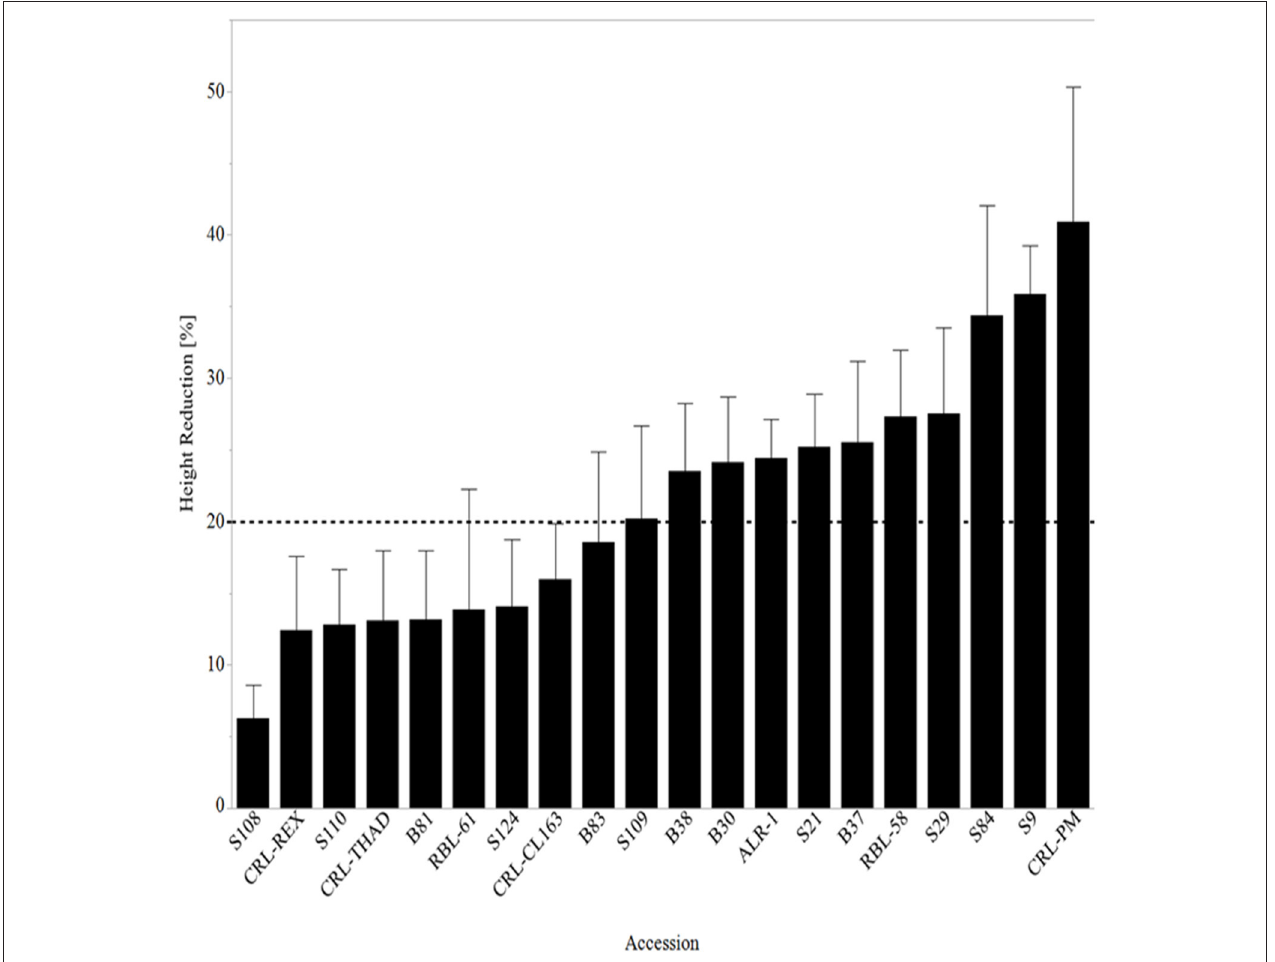
FIGURE 2 | Mean height reduction 28 days after heat stress treatment arranged from lowest reduction to the highest reduction in height. The line at 20% represents all lines with ≥ 20% reduction in height. RBL, Rice breeding line; CRL, cultivated rice